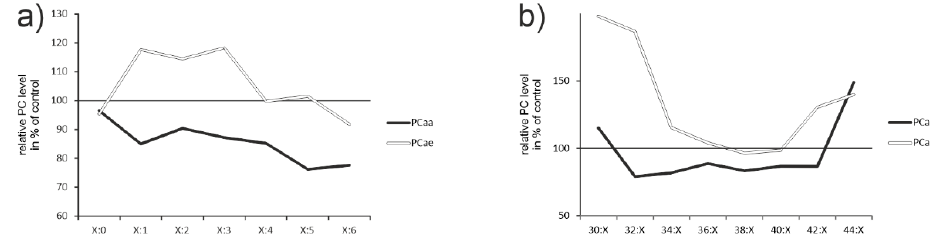
Figure 4. Saturation and chain length of phosphatidylcholines in liver tissue from acitretin-treated mice. Processing of the data regarding saturation ( a ) and chain length ( b ) included the following